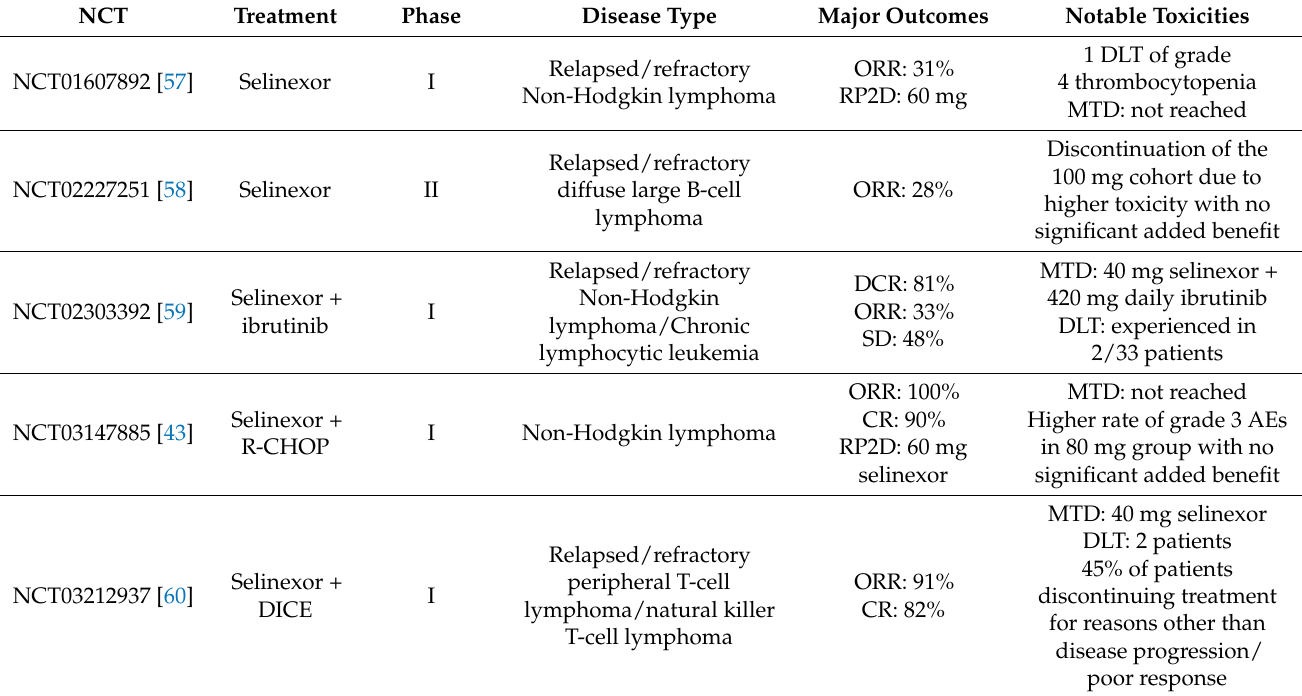
Table 4. Completed Clinical Trials for Selinexor Treatment in Non-Hodgkin